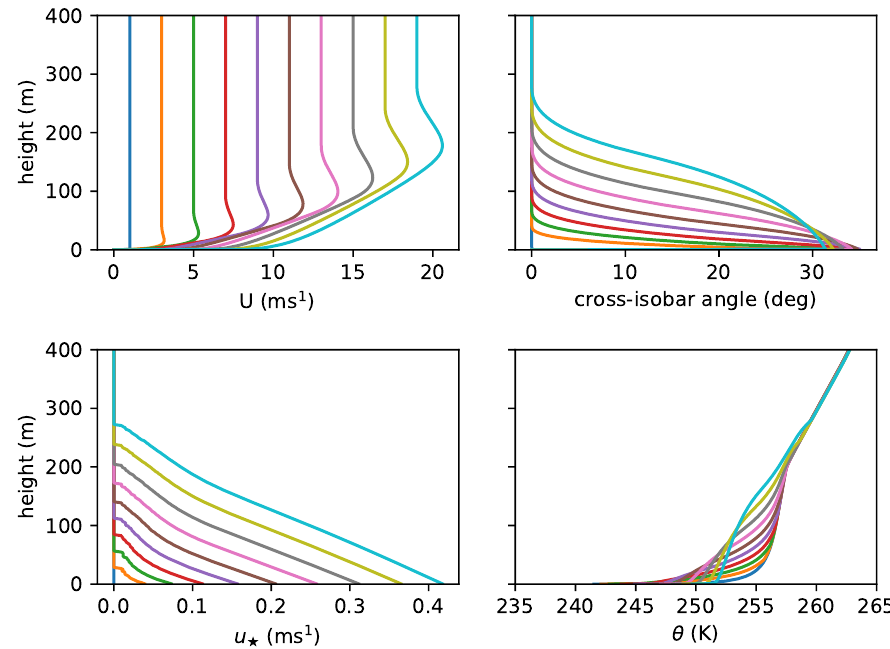
Figure 5. Vertical profiles of wind speed and direction, u (cid:63) , and the potential temperature simulated by the single-column model after 24 h of cooling. Colors correspond to various values of the geostrophic wind